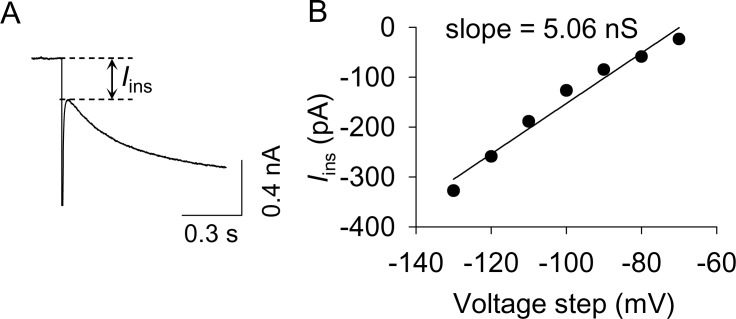
The measurement of resting membrane conductance.(A) The instantaneous inward current (Iins) was measured as indicated by the dashed lines. (B) A representative example for calculating resting membrane conductance. Iins was plotted against the hyperpolarizing voltage steps. The slope of these I-V curves is indicative of the resting membrane conductance shown in Figure 4G.